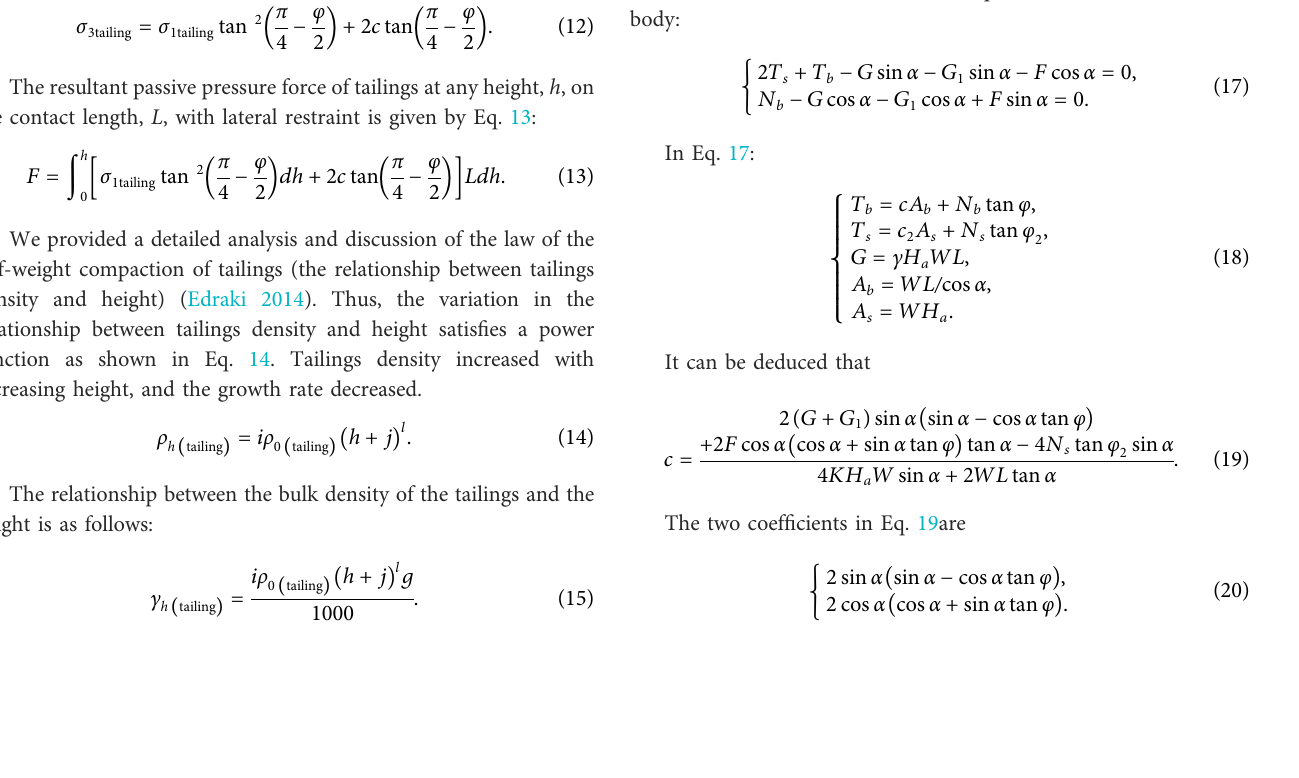
When the lateral restraint was displaced or rotated relative to the direction of the tailings packing body under the action of an external force, the tailings packing body was squeezed, resulting in a tendency to upward sliding failure. When the horizontal stress exerted by the outside was greater than the vertical self-weight stress of the tailings and becomes the maximum principal stress, the tailings were compressed in the horizontal direction and their damage was affected by the resistance of the shearing force of the tailings. The tailings were in a passive state, and as the relative displacement of the con fi nement constraint increased, the horizontal stress of the tailings increased accordingly until the shear stress on the sliding surface reached the shear strength of the tailings. Consequently, the tailings were in a passive limit equilibrium state as shown in Figure 11. The angle between the slip plane of the tailings and the maximum principal stress action surface (vertical plane) was 45 ° + φ /2, and the angle between the slip plane and the horizontal plane was 45 ° - φ /2. tailings is shown in Eq. 12: